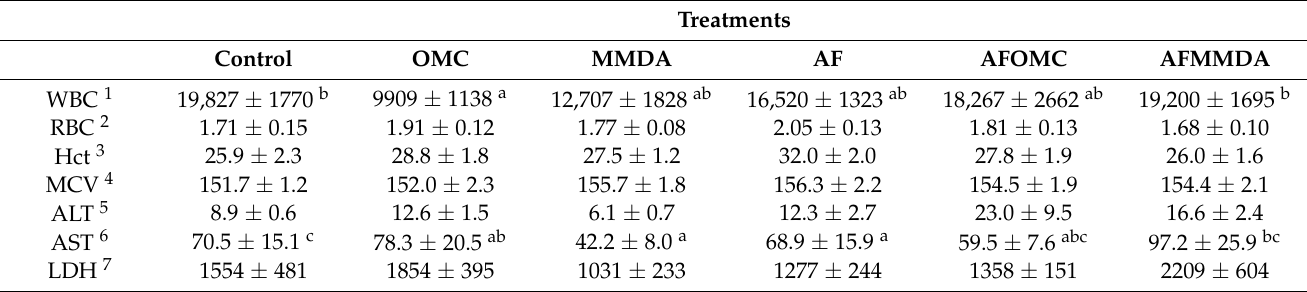
Table 4. Hematological blood parameters of Nile tilapia.